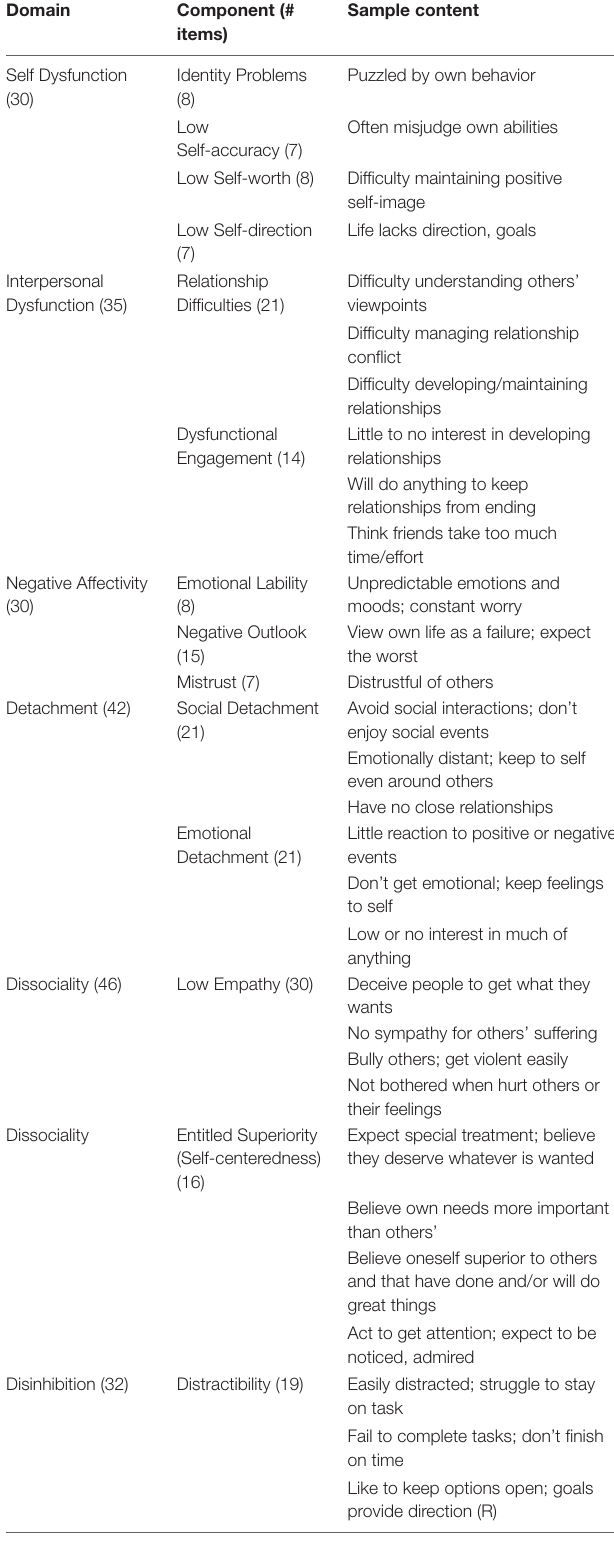
TABLE 1 | Preliminary empirically derived domain and component scales of the ICD-11 personality disorder